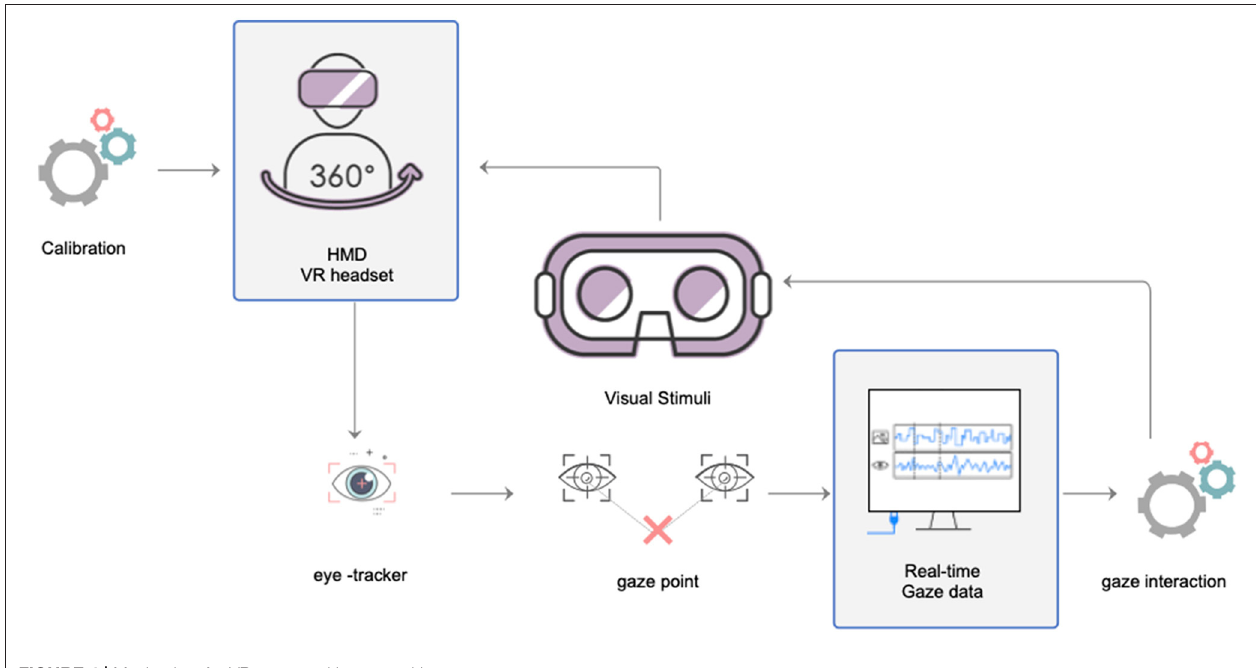
FIGURE 4 | Mechanism for VR system with eye-tracking.